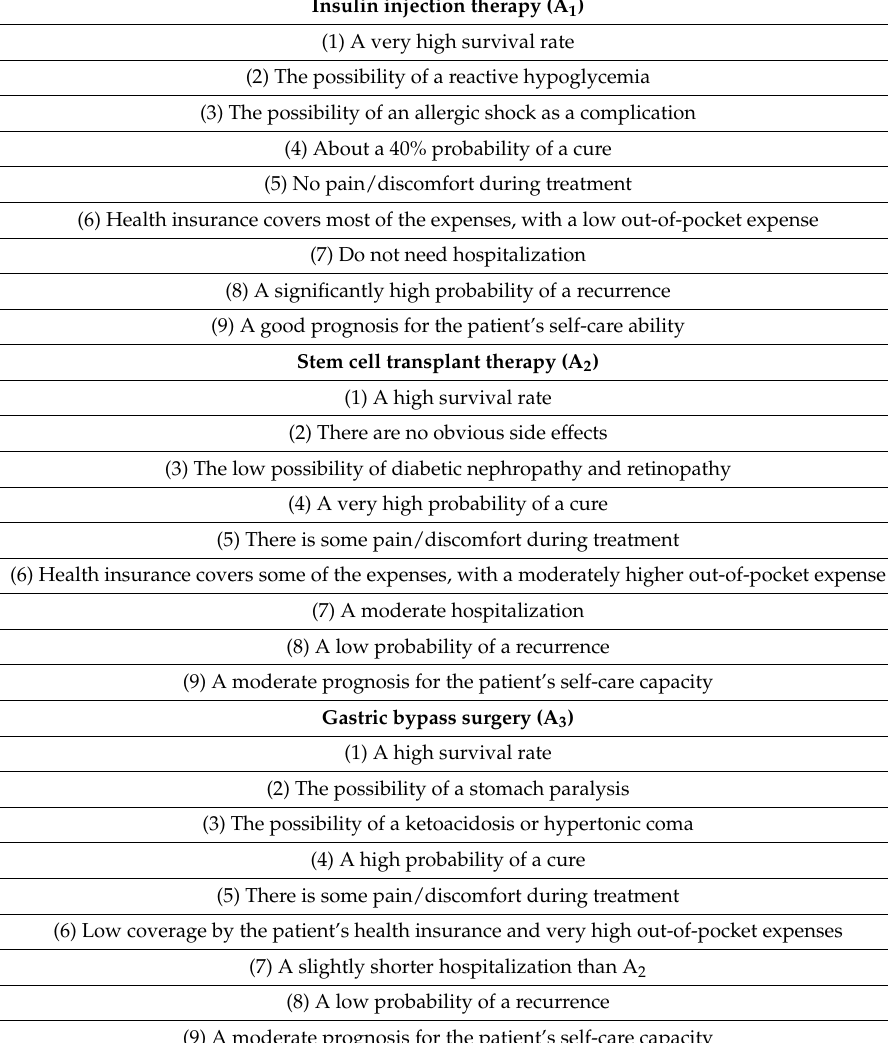
Table 3. Descriptions of the treatment